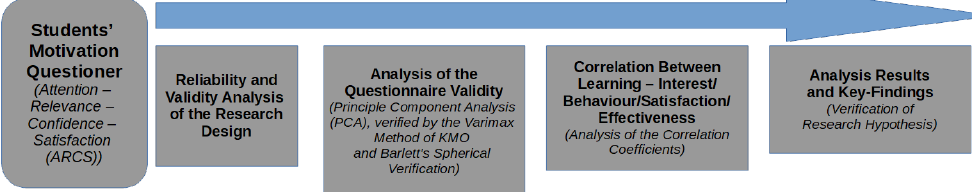
Figure 5. Various stages of testing the student’s motivation through a quantitative anal ysis.